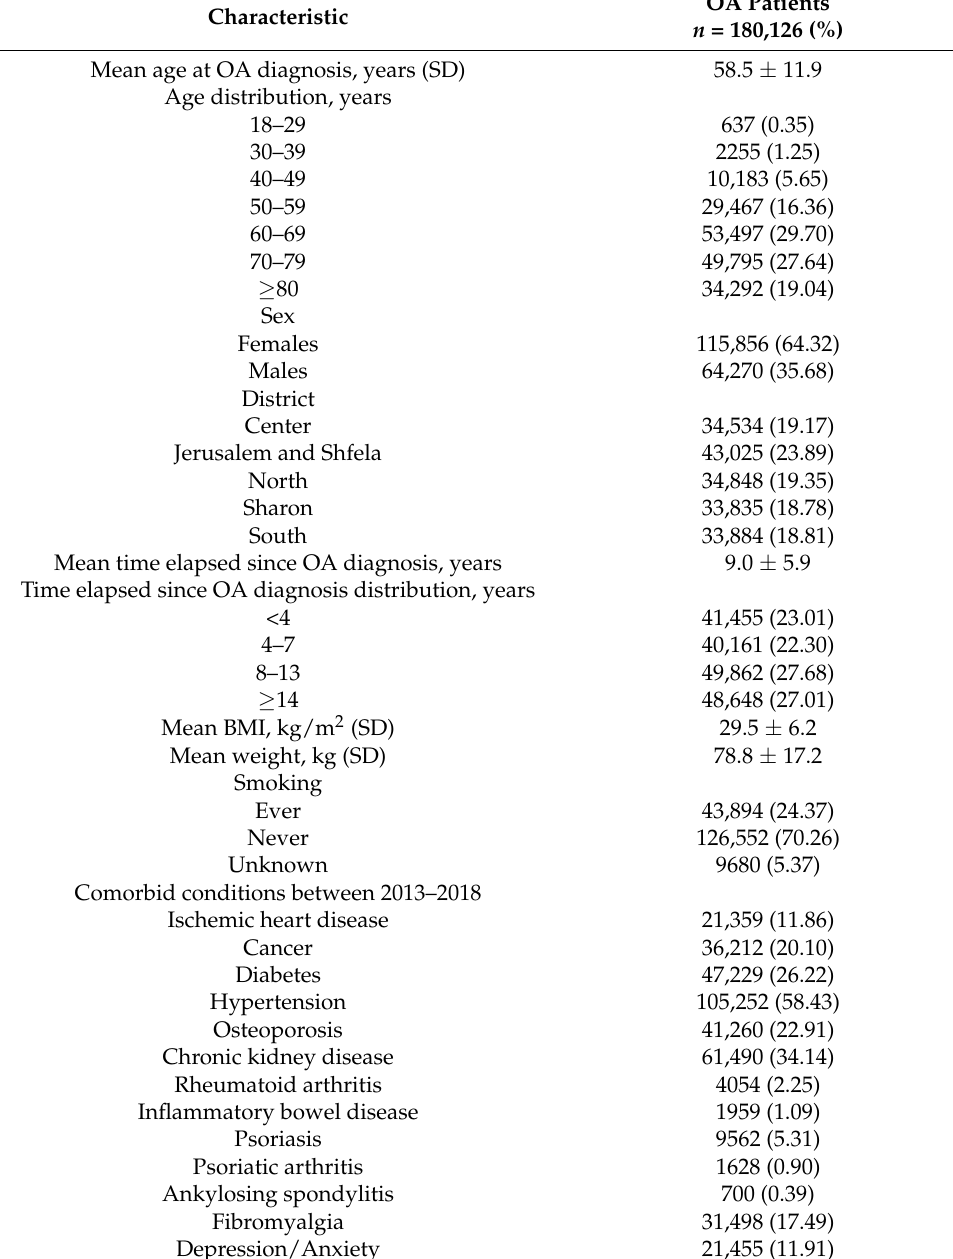
Table 1. Characteristics of the study population in